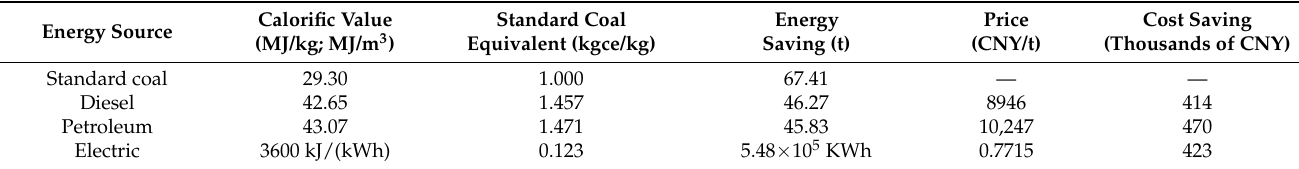
Table 10. Energy consumed per km of LSPM pavement.